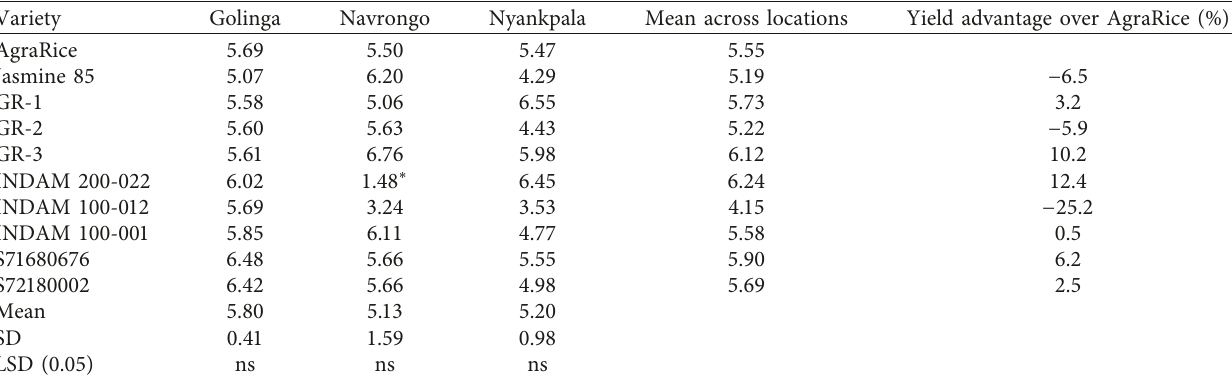
Table 5: Yield (t/ha) of hybrids and checks across locations in 2014.